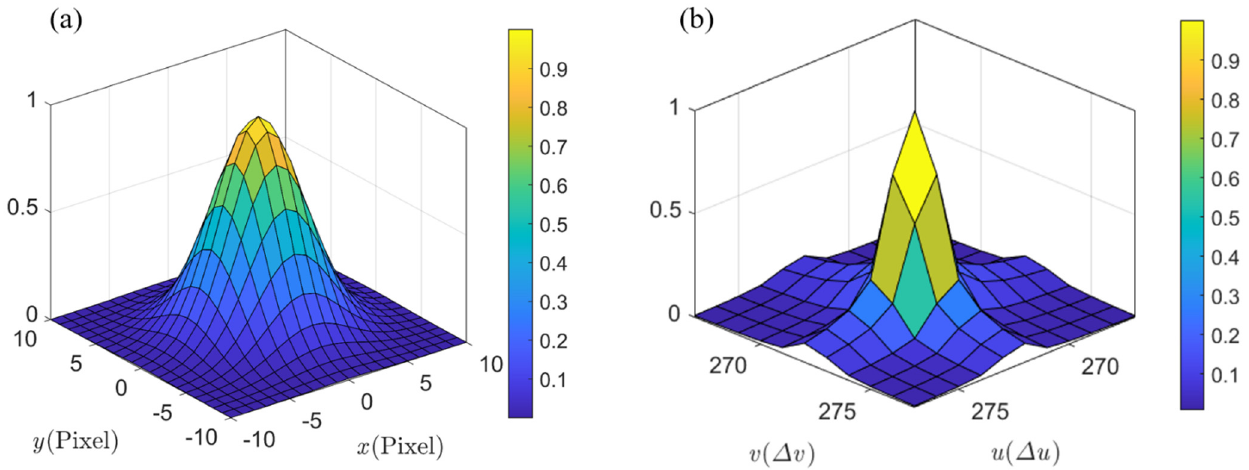
Figure 1. Gaussian function and spectra distribution on an SSP ( a ) a Gaussian distribution in the spatial domain ( b ) one of the frequency peaks in the Fourier spectra domain.